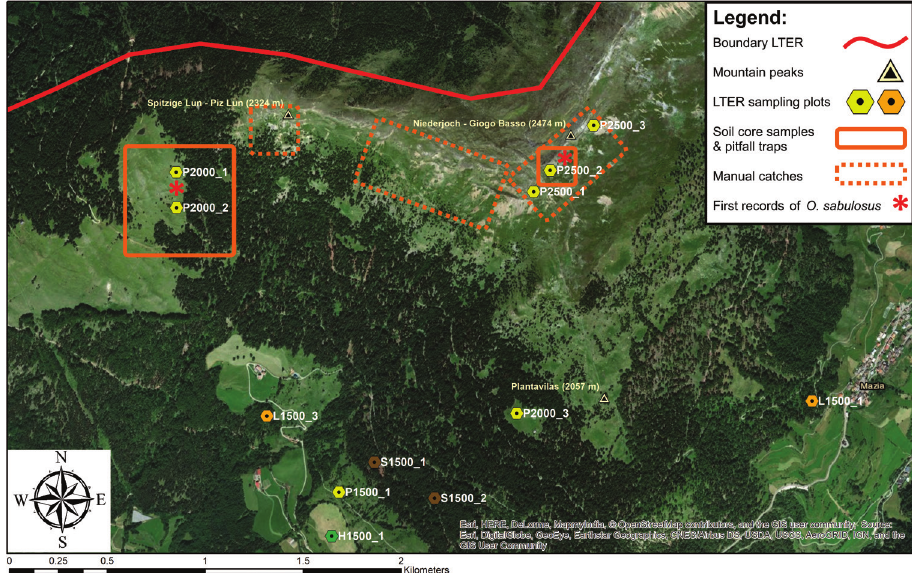
Figure 1. Aerial photograph of the upper “Muntatschinig” site in the LTSER area “Val Mazia/Matscher- tal” with the samplings from 2016 to 2018. The orange frames depict the Opetiopalpus sabulosus Mots- chulsky, 1840 (Coleoptera: Cleridae) sampling areas, hexagons the locations of permanent monitoring sites (e.g. L1500: Larch forests at 1500 m a.s.l., H1500: hay meadows, S1500: Spruce forests, P2000: dry pastures at 2000 m, etc.). Table 1. List of samplings and methods at the “Muntatschinig” site in the LTSER area “Val Mazia/Mat- schertal” to find Opetiopalpus sabulosus Motschulsky, 1840 (Coleoptera: Cleridae). The sampling areas in- clude steppe-like dry pastures at different elevations (e.g. P2000_1 represents plot number one of dry pas- tures P at approximately 2000 m a.s.l.) as well as summit areas. Details for each sampling date are